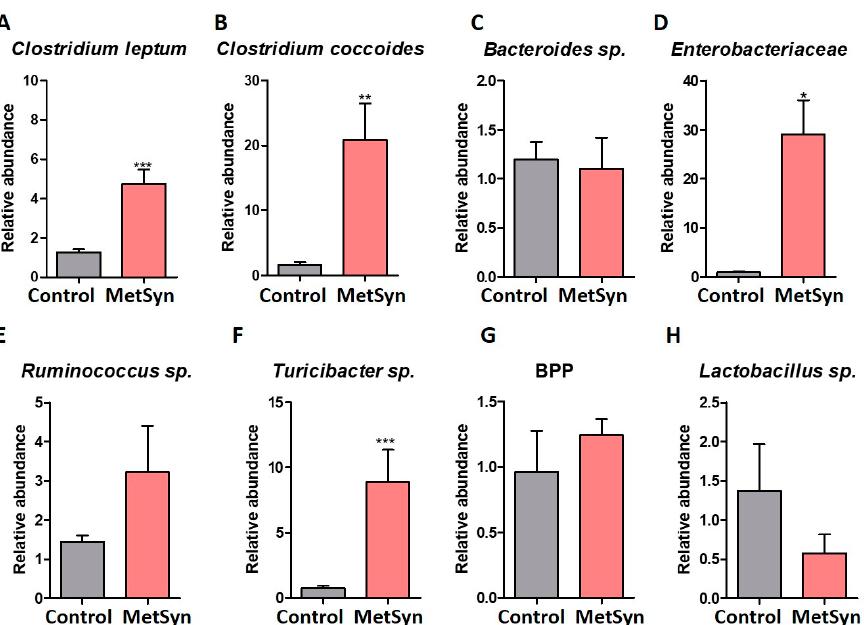
Figure 2. Bacterial population analysis in MetSyn patients ( n = 30) versus healthy controls ( n = 30). The relative abundance of Clostridium leptum ( A ), Clostridium coccoides ( B ), Bacteroides sp. ( C ), En- terobacteriaceae ( D ), Ruminococcus ( E ), Turicibacter ( F ), Bacteroides-Porphyromonas-Prevotella ( G ), and Lactobacillus sp. ( H ) in fecal samples harvested from healthy individuals and MetSyn patients; * p < 0.05, ** p < 0.005, *** p < 0.0001, Mann–Whitney test.